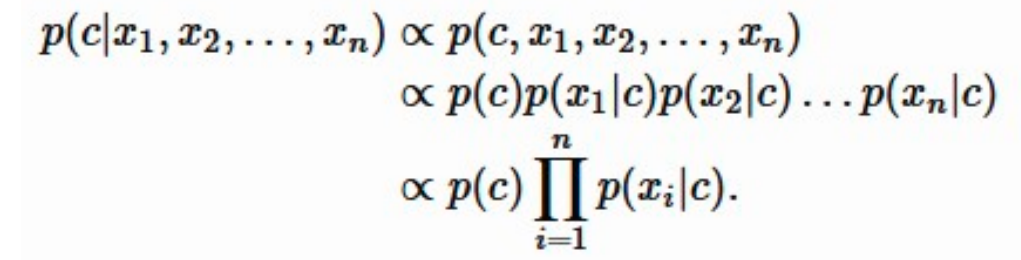
Figure 6. The Naïve Bayes algorithm.